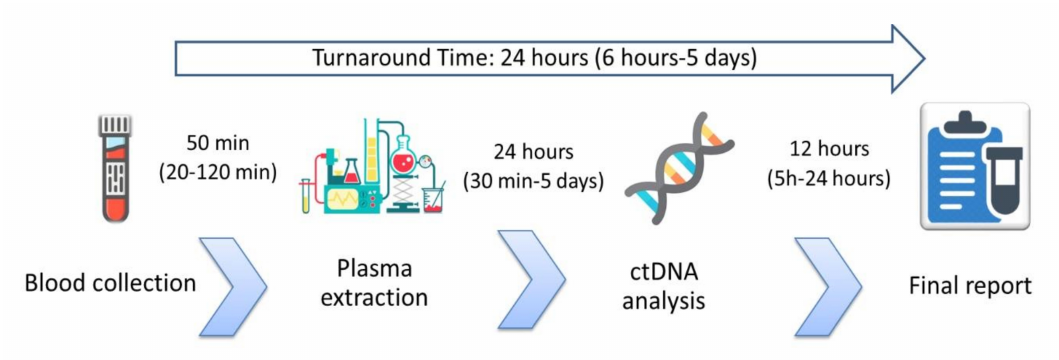
Figure 1. Turnaround time and workflow steps timing. Data are reported as median